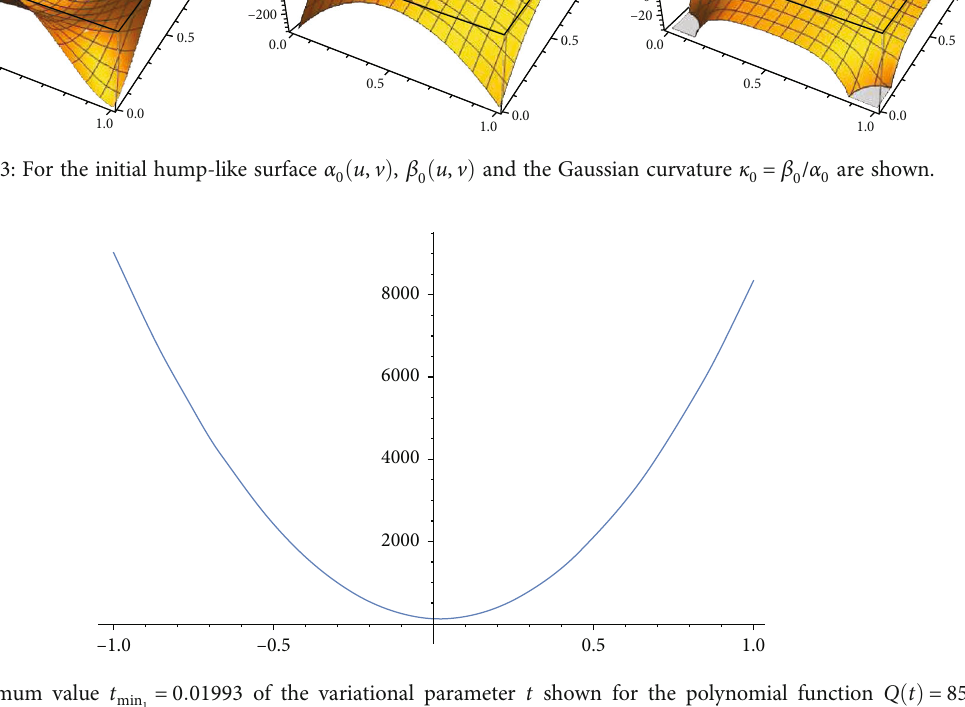
Figure 3: For the initial hump-like surface α